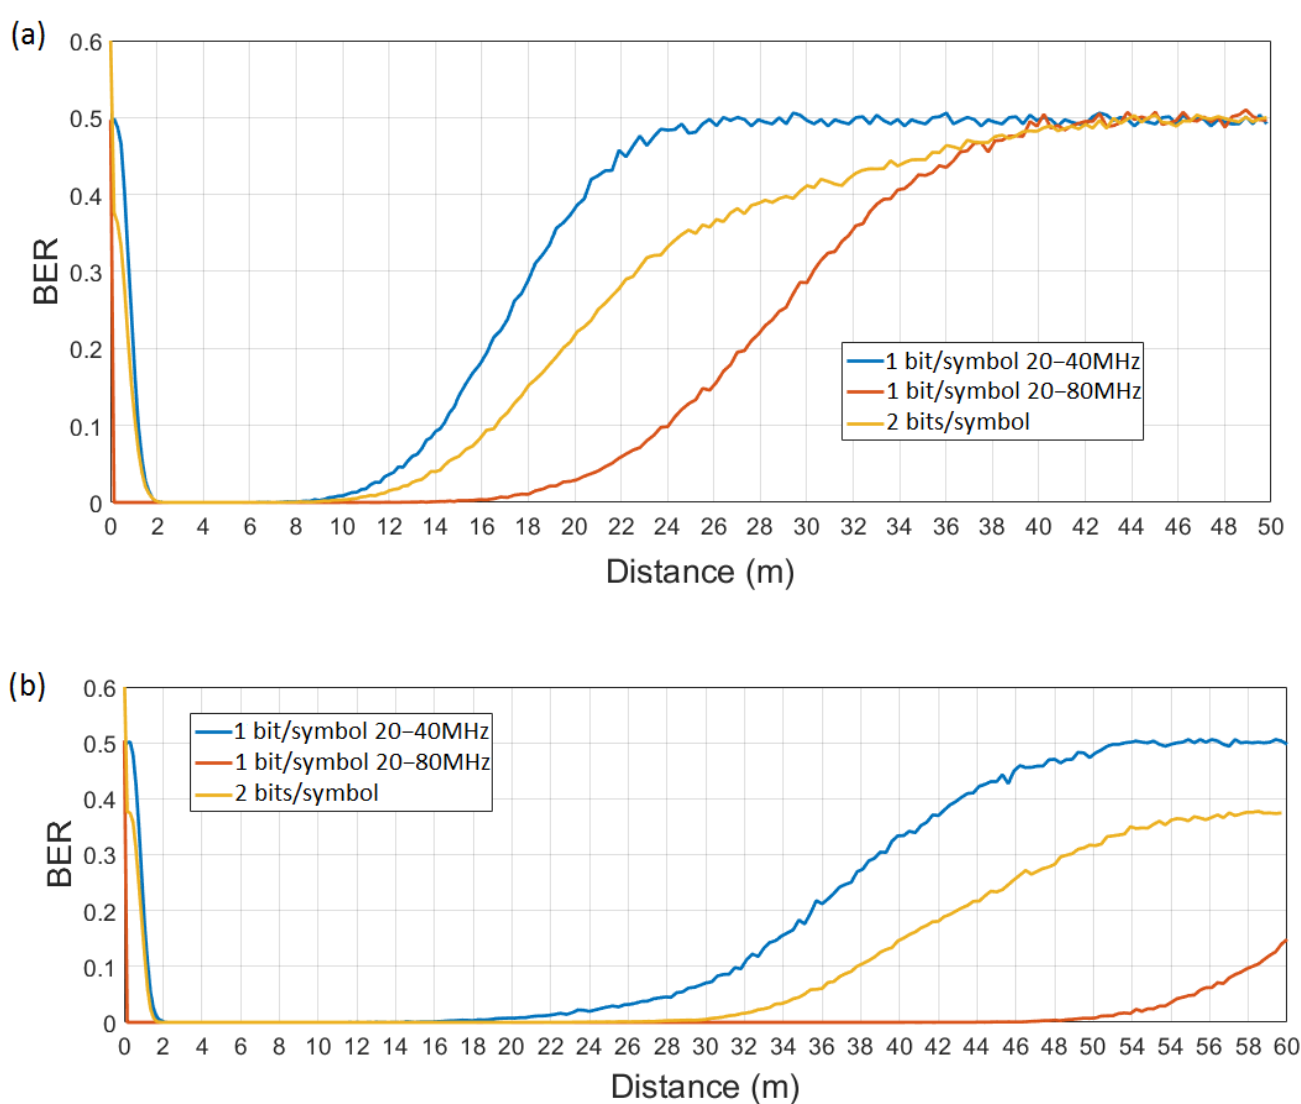
Figure 11. BER at WuRx output of Figure 6 vs. distance, for propagation model B ( a ) and F ( b